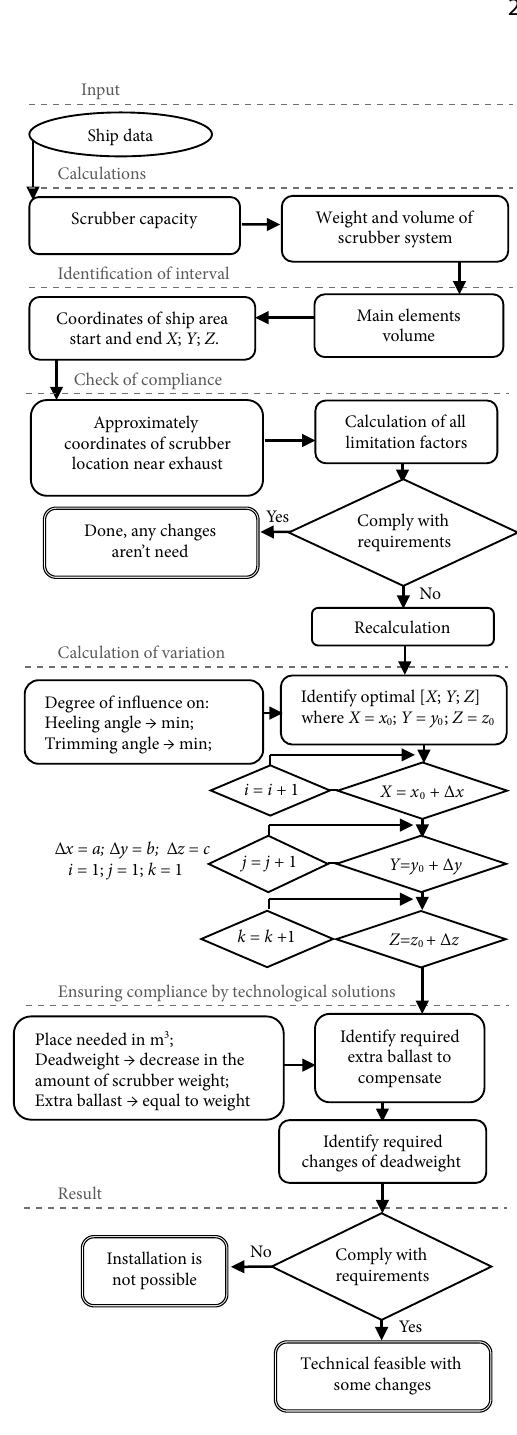
Fig. 6. The algorithm of assessment of scrubber system